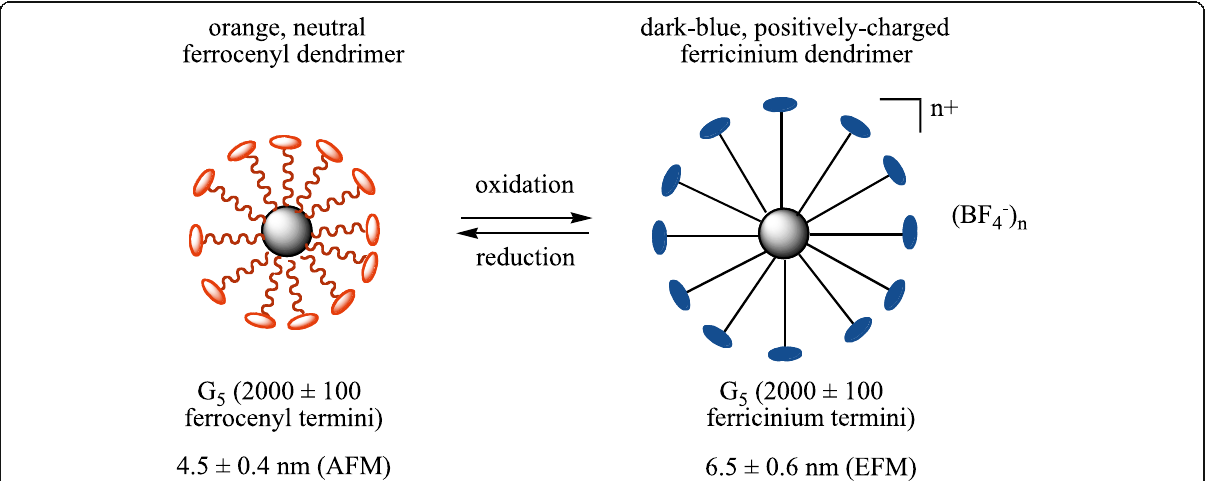
Fig. 5 Reversible “ breathing ” (about 50% size increase) of giant ferrocene-terminated dendrimers acting as a molecular machine upon oxidation to polycationic Fe(III) dendrimers due to mutual repulsion of positively charged redox centers in the Fe(III)